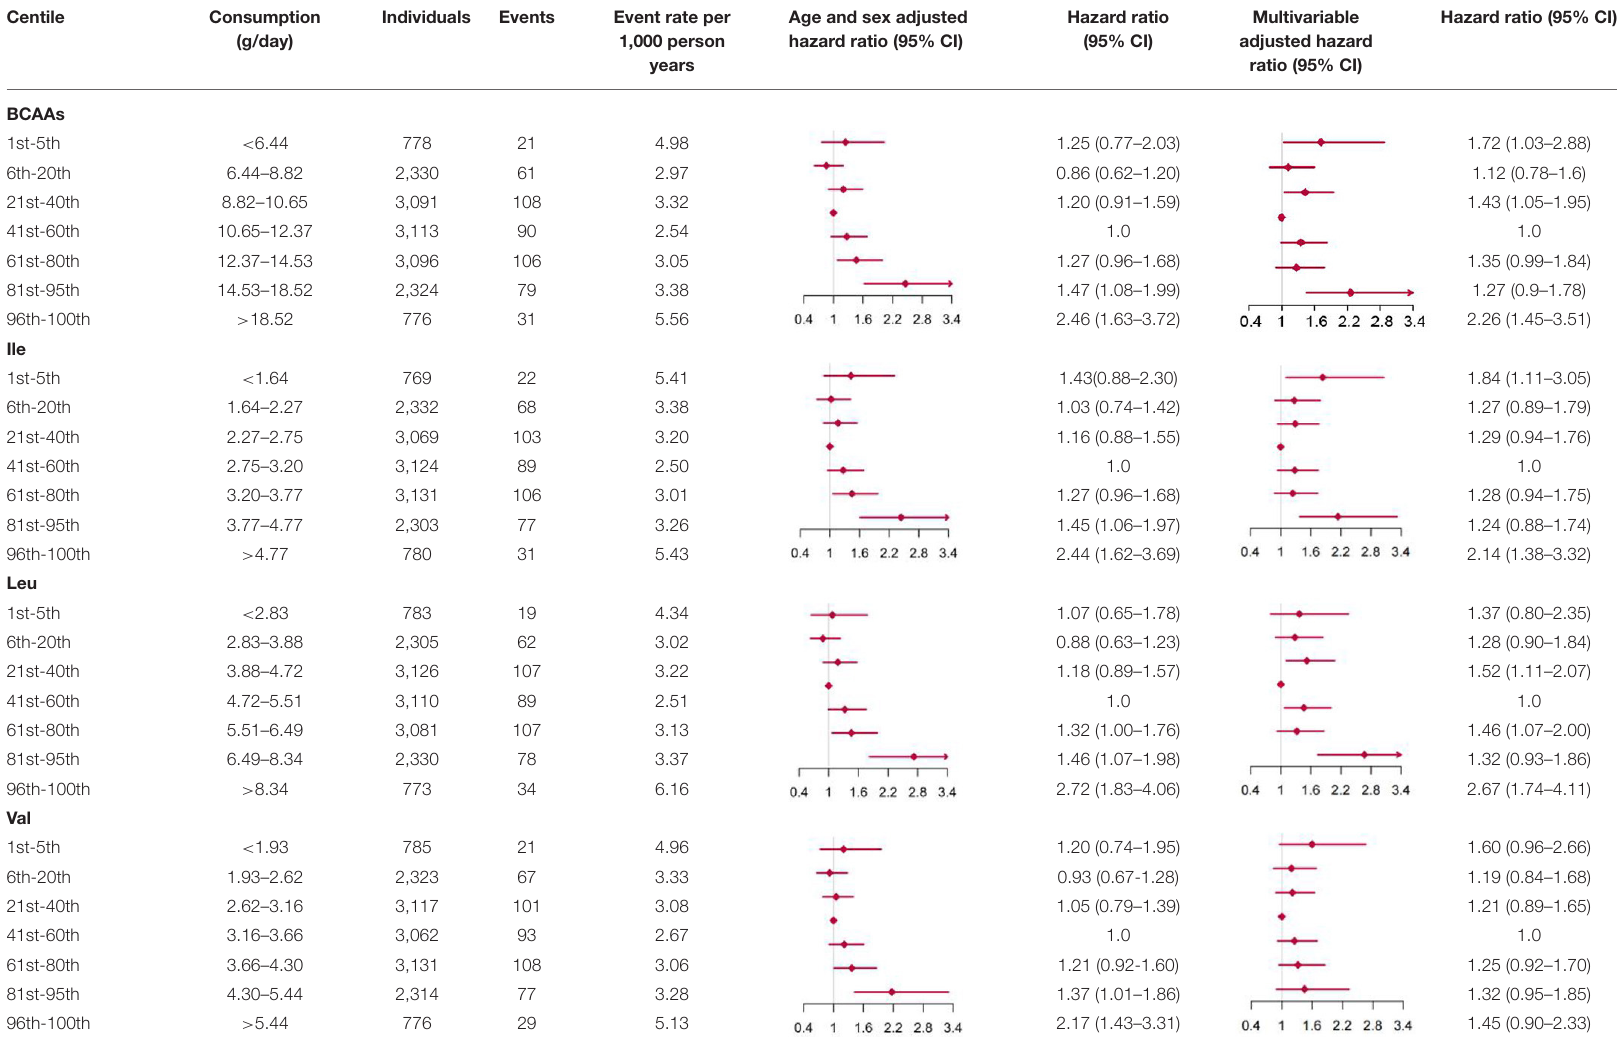
TABLE 5 | Hazard ratios for incident type 2 diabetes according to categories of levels of BCAAs (Ile, Leu, Val) intake, sex and age adjusted, and multivariable adjusted.